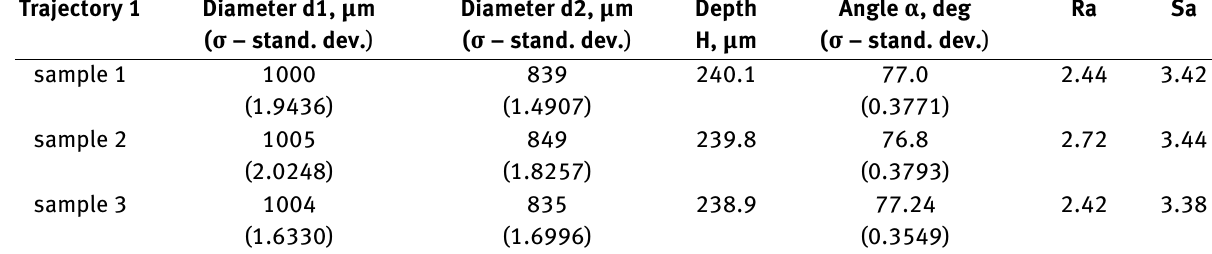
Table 1: List of measurement results for trajectory 1.